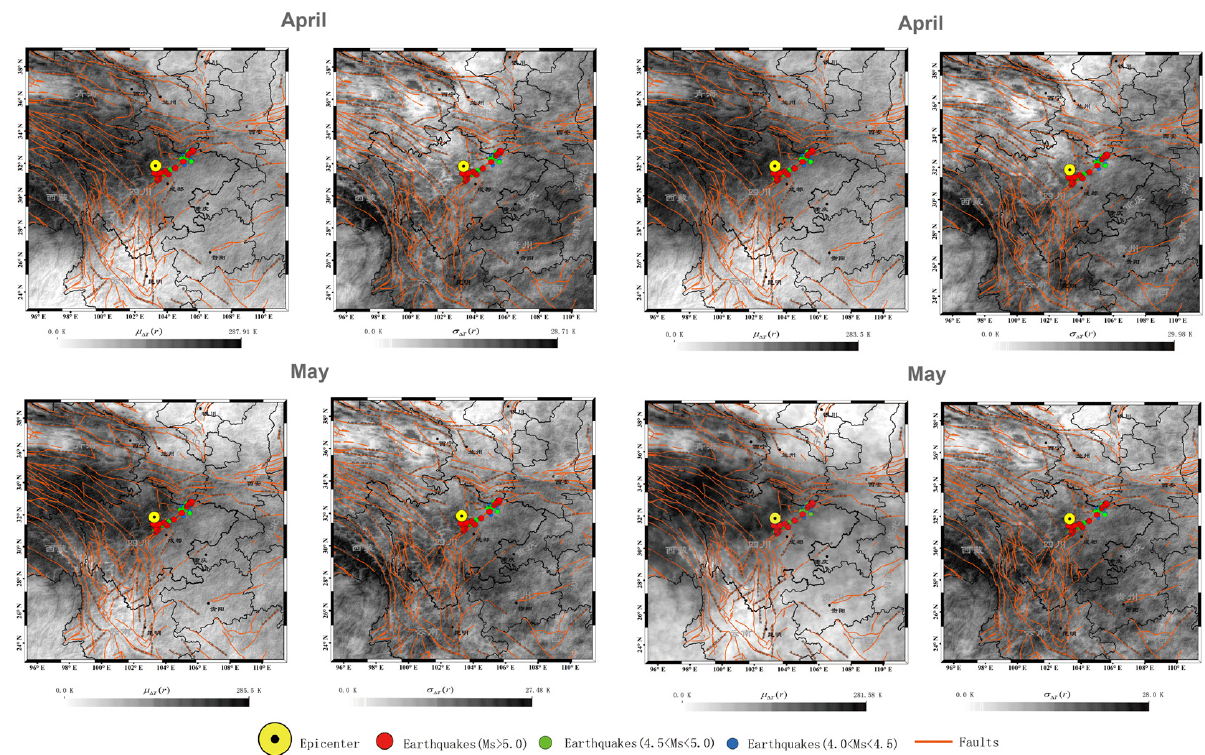
Figure 2. The reference field for the investigated area of forward view and nadir view computed from bi-angular AATSR data from 2003 to 2008 during the months of April (left panel) and May (right